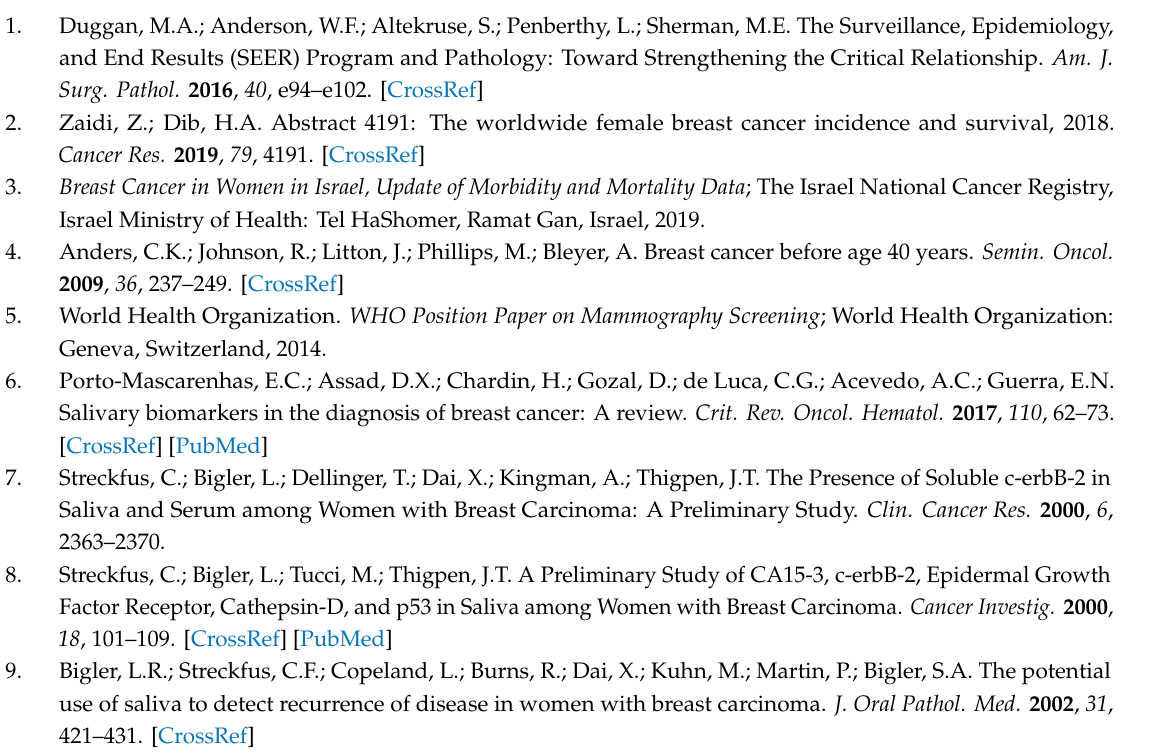
Table S1: List of primers used in this study; Table S2: List of 28 splicing factors identified in RNA-seq; Figure S1: RNA-seq snap shots of validated splicing factors; Figure S2: Reproducibility and diversity measurement of each splicing factor; Figure S3: Results from cell-free saliva of 36 healthy and 31 breast cancer patients. Author Contributions: M.B. and M.S., designed the experiments, analyzed the data and wrote the manuscript; M.B., conducted all experiments; A.G.M. and L.M., were responsible for collection of the samples; M.T., was in charge of patient selection; G.M. and A.B.-H., analyzed the data; G.K., designed the experiments; Y.N., analyzed the RNA-seq data; T.P., O.M. and R.B., were responsible for characterization and acquisition of clinical data; T.P., supervised sample and data collection and analysis of the data and contributed to the manuscript. All authors have read and agreed to the published version of the